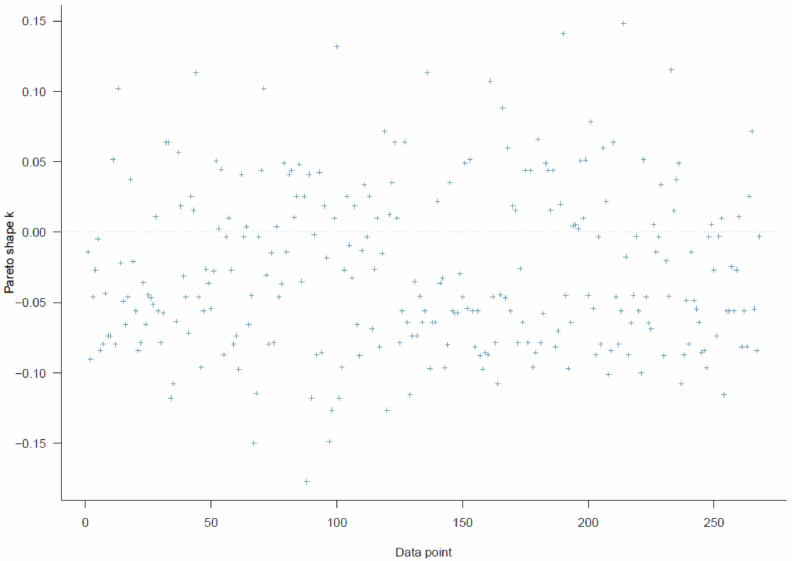
Figure 16. Model 4 (cid:48) s PSIS diagnostic plot.